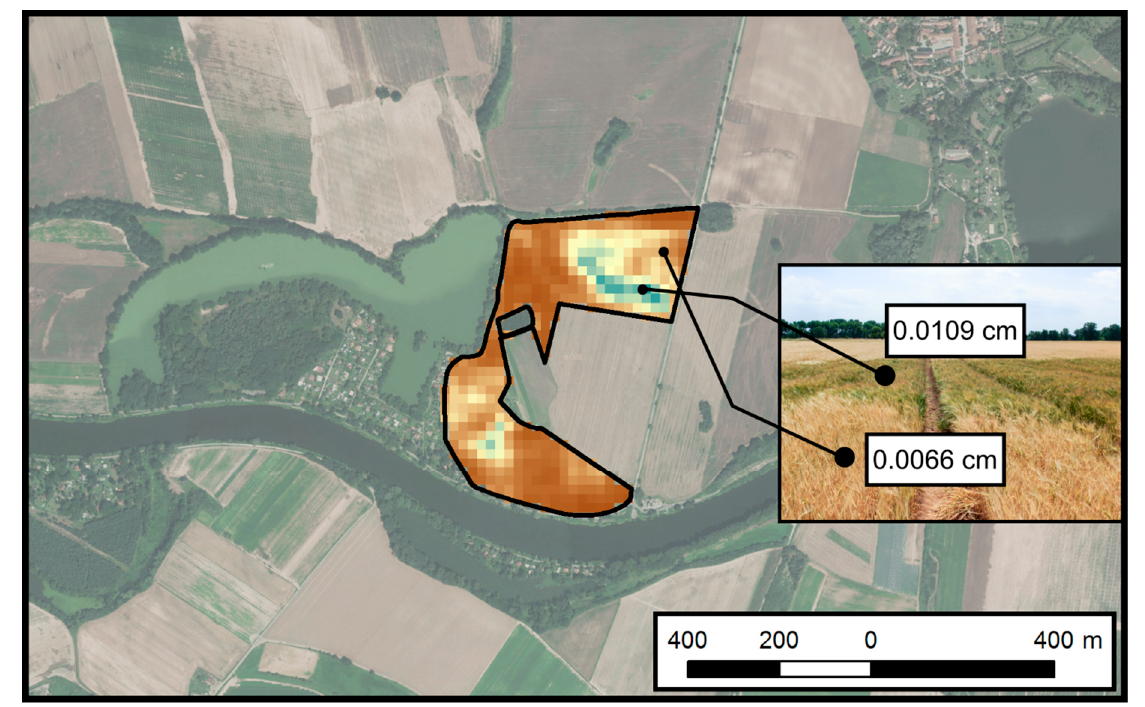
Figure 12. Example of leaf water content (LWC) estimation for a spring barley parcel. The remnant of river (now filled by fluvial sediments) is a local topographic sink with higher soil wetness that influences the LWC of the cultivated crops (20 June 2017).